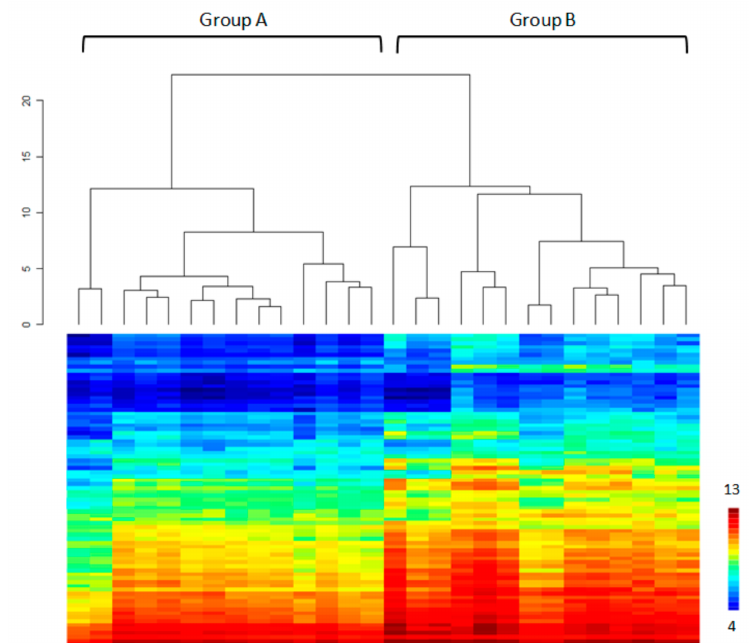
Figure 1. Unsupervised hierarchical clustering of basal kinase activity profiles among non-small-cell lung cancer patients peripheral blood mononuclear cells (PBMC). The heatmap represents phosphorylation levels (Log2Signal) for 80 peptides (Y-axis) sorted by hierarchical clustering. Two distinct clusters can be observed among the 28 patients’